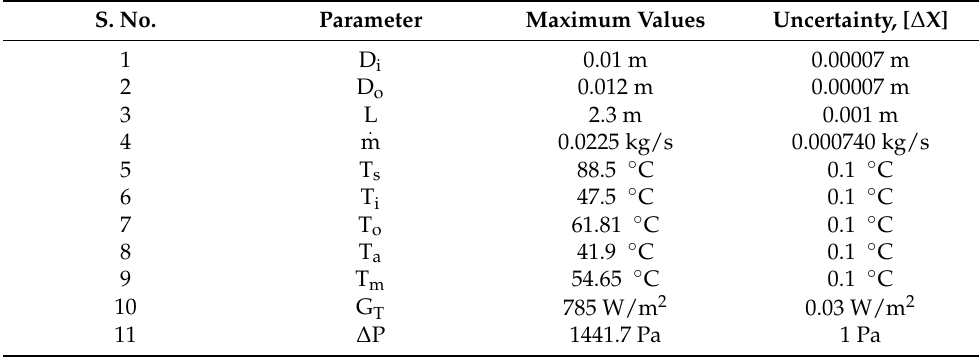
Table 8. The measured parameters, their maximum values, and their uncertainties. S. No.